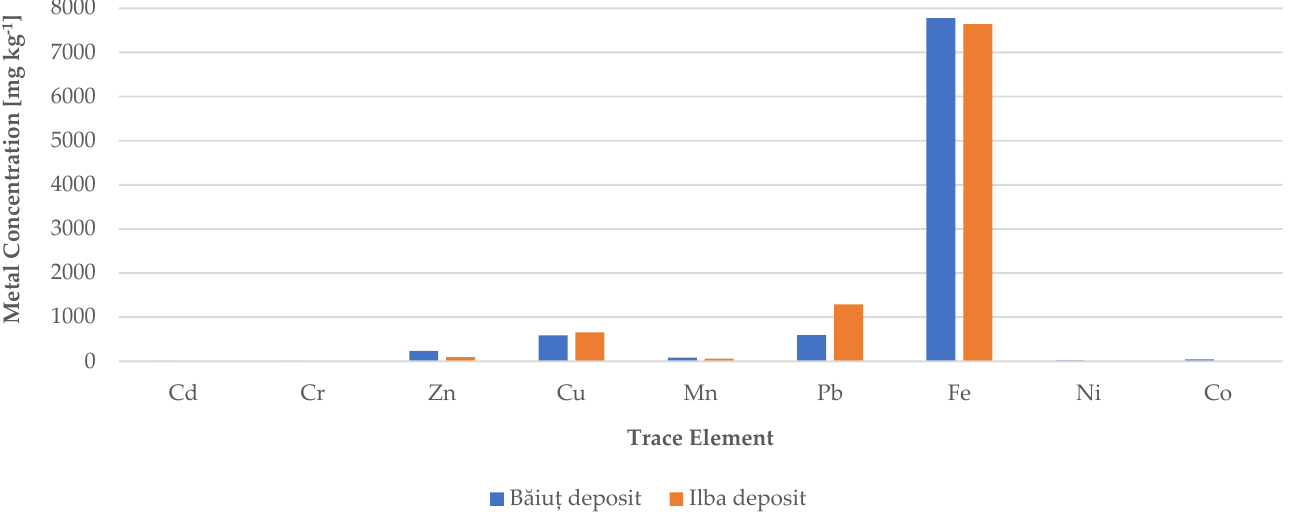
Figure 14. Mean trace element concentrations in the sterile mining dumps, based on ICP − OES de- terminations.